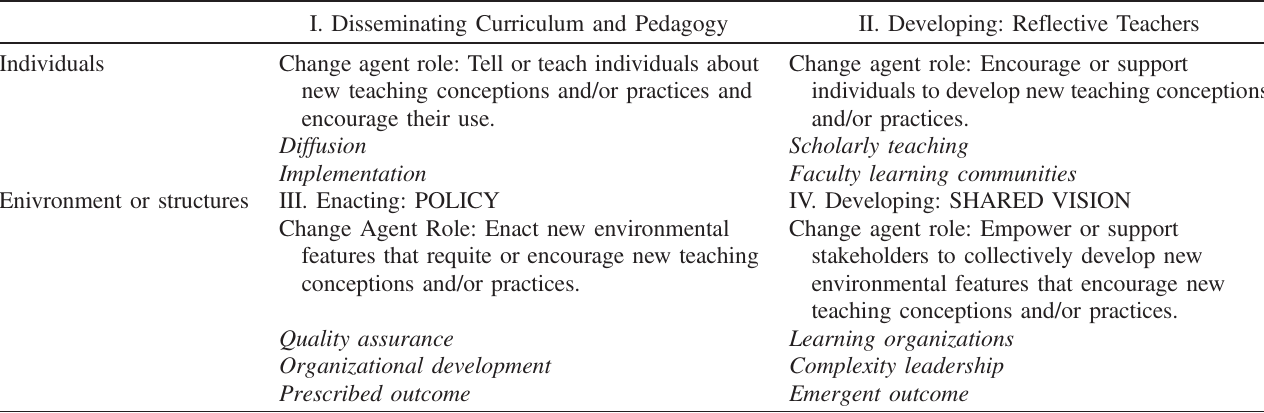
TABLE I. Change strategy characterization as outlined by Henderson et al. in Refs. [10,21]. The italics list 8 important change strategies implied by these categories.